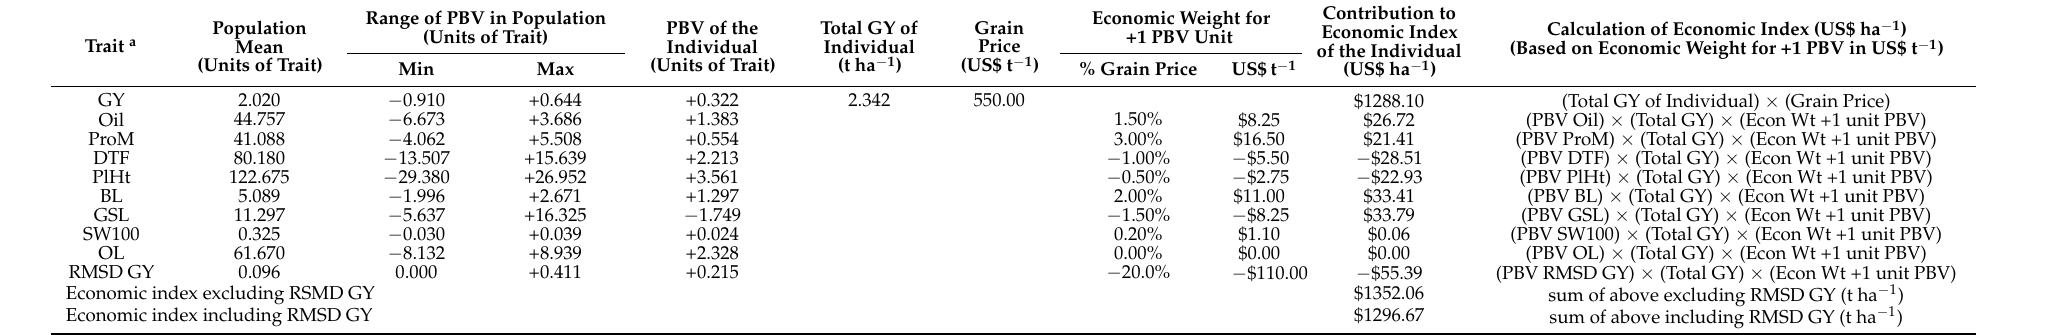
Table 2. Calculation of economic index based on economic weights for traits to achieve desired genetic gains in a hypothetical genotype in cycle 4. The assumed grain price is US$550 t − 1 . The economic weight of a trait for +1 unit predicted breeding value (PBV) is shown as % grain price and in US$ t − 1 . The contribution of a trait to the economic index in US$ ha − 1 is calculated by multiplying the economic weight for +1 PBV unit (US$ t − 1 ) × PBV of the individual in units of trait × total GY of individual (t ha − 1